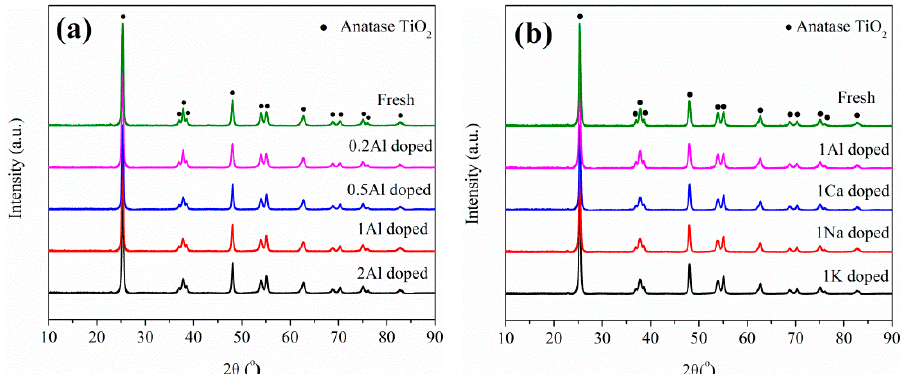
Figure 5. XRD patterns of various catalysts: ( a ) fresh (1V-5W/Ti) and Al doped catalysts with different Al/V molar ratios, and ( b ) fresh and 1 M doped catalysts (M = Al, Ca, Na, and K).